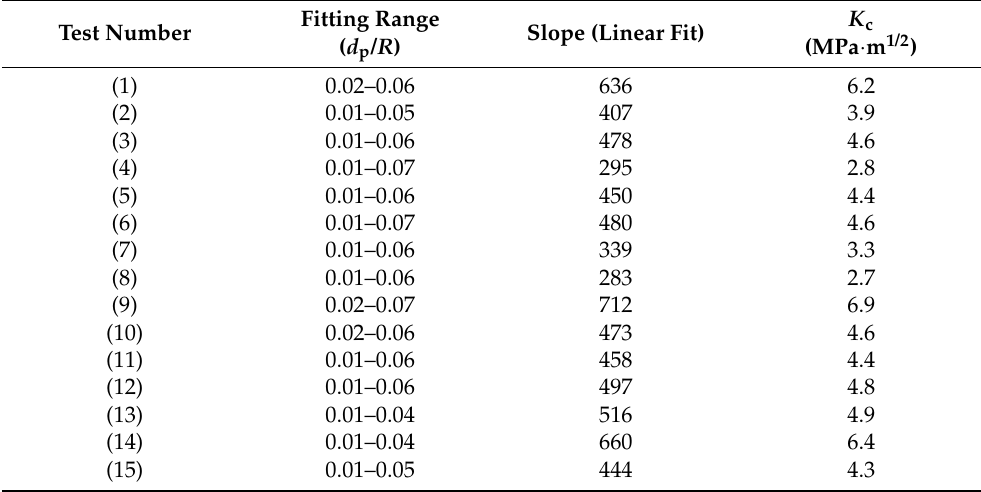
Table 2. The fitting range of F l ( d p /R ) curves and the related slopes used for the calculation of the fracture toughness of the Al 2 O 3 coatings.